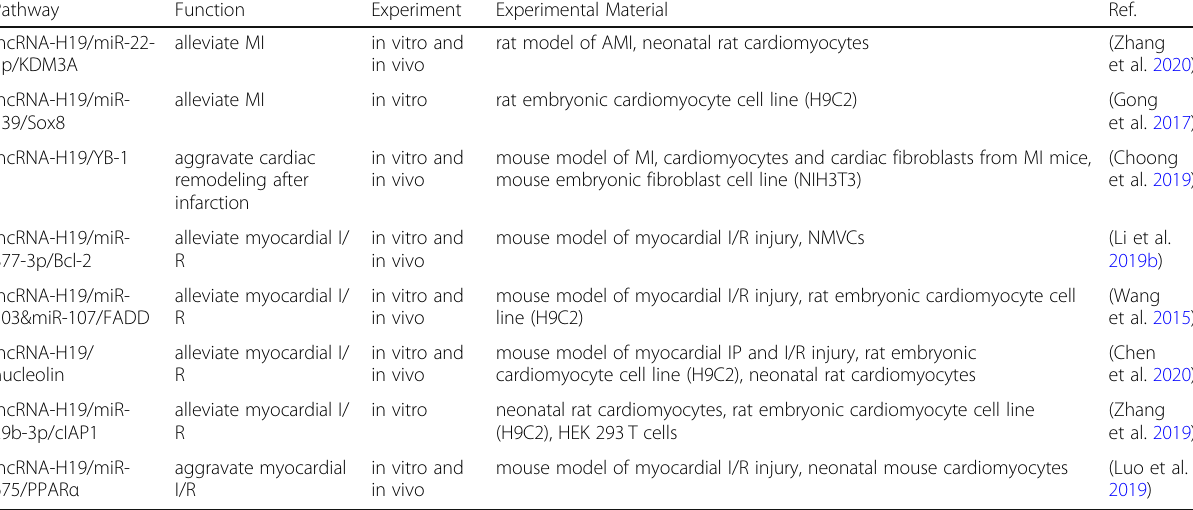
Table 1 The pathways of lncRNA-H19 in atherosclerosis-related pathophysiological processes (Continued) Pathway